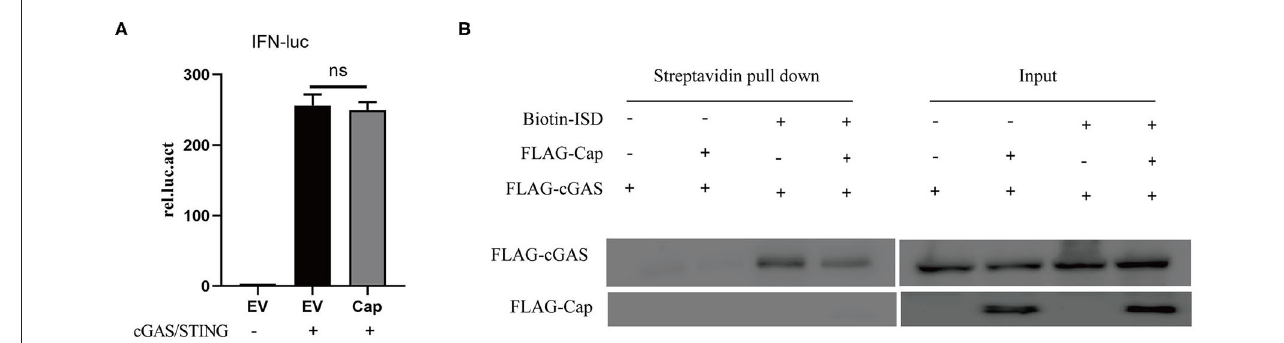
FIGURE 2 | PCV3 Cap inhibits cGAS binding to DNA. (A) PCV3 Cap did not affect IFN promoter induction by cGAS and STING. HEK 293T cells were co-transfected with IFN-Luc, TK-Luc, FLAG-Cap, empty vector (EV), FLAG-cGAS, and FLAG-STING. At 24 hpt, the cell lysates were prepared for luciferase analysis. (B) Cap inhibits ISD binding of cGAS. HEK 293T cells were co-transfected with FLAG-cGAS, FLAG-Cap, or the empty vector (EV). At 24 hpt, the cells were transfected with biotin-ISD for another 2h, and the cell lysates were prepared from them for biotin-ISD pull-down and immunoblotting analysis.